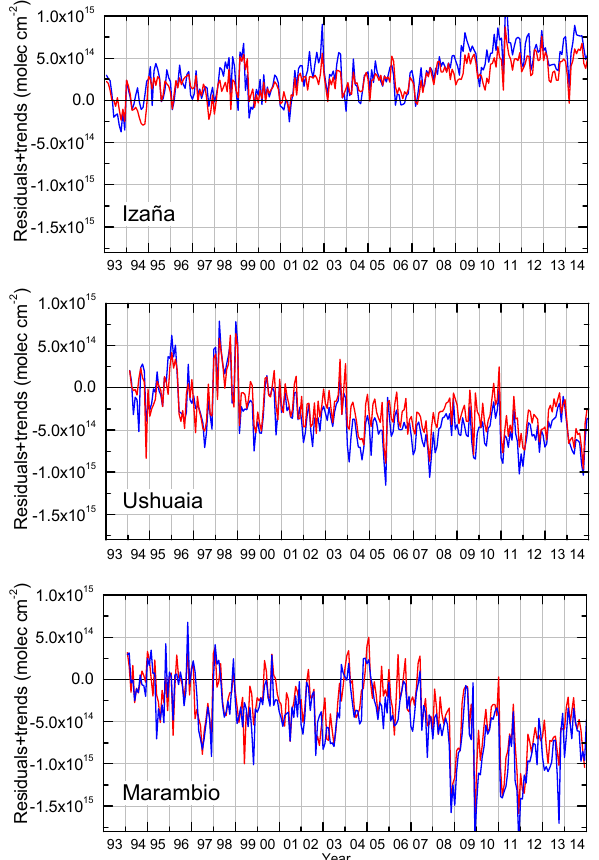
Figure 1. NO 2 vertical column density time series (blue lines) and fit obtained using the multiple linear regression model (red lines). Figure 2. Fit residuals: observations minus models without trends. Red lines: AM data. Blue lines: PM data.